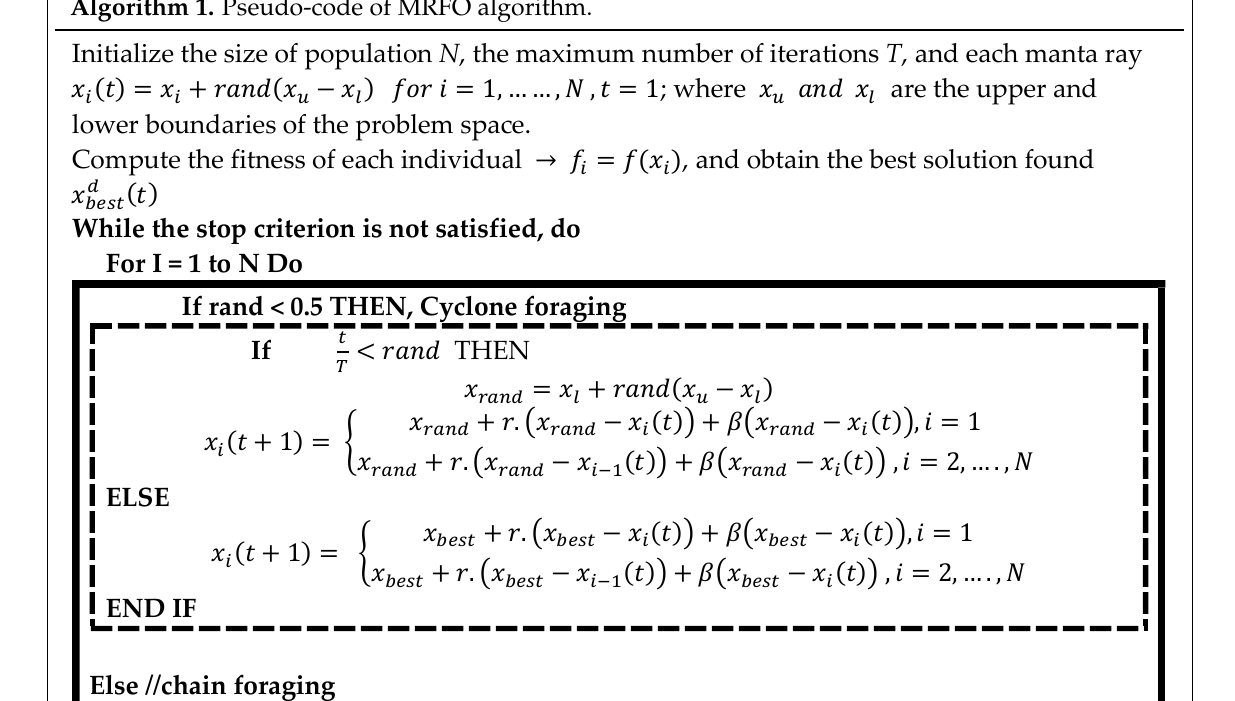
Algorithm 1. Pseudo-code of MRFO algorithm.